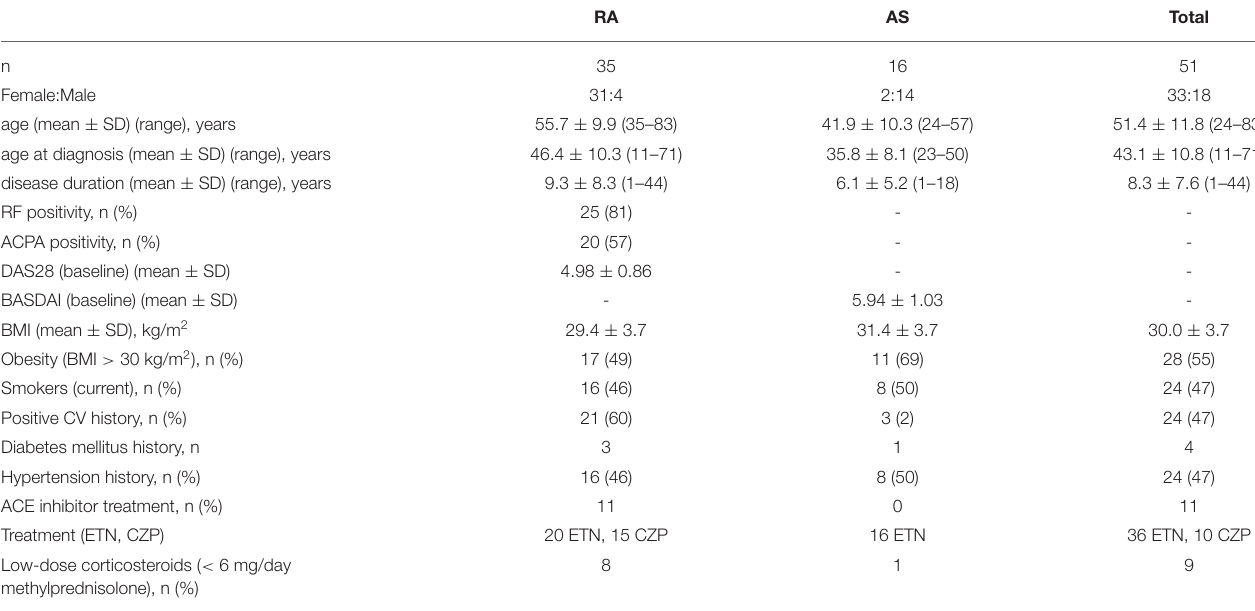
TABLE 1 | Patient characteristics.